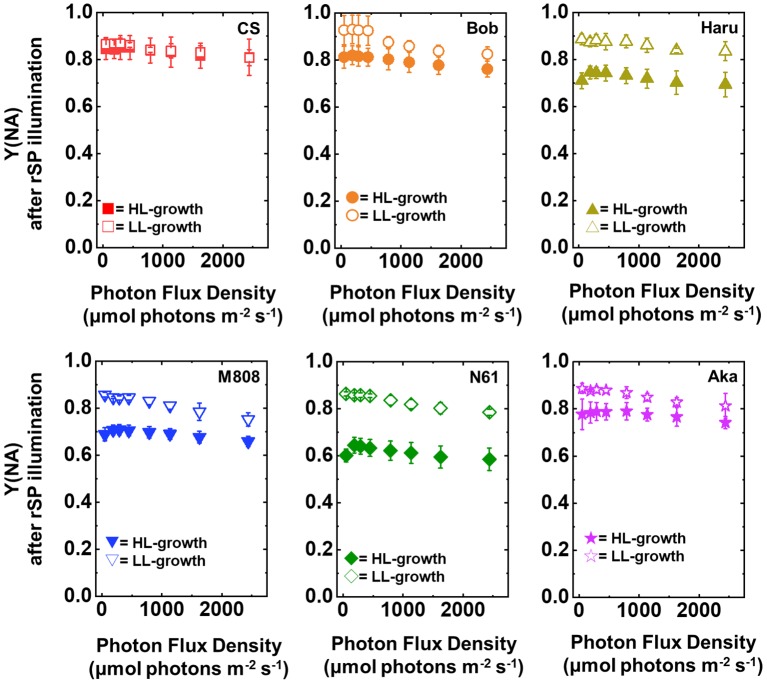
The response of Y(NA) to light intensity in six wheat cultivars grown under LL (open symbol) and HL (closed symbol) conditions after rSP illumination for 1 h. The measurement was conducted under atmospheric conditions (21 kPa O2, 40 Pa CO2) at 25°C. Data are expressed as mean ± SD of three to four independent experiments. Red squares indicate the results of CS, orange circles indicate the results of Bob, dark yellow triangles indicate the results of Haru, blue inverted-triangles indicate the results of M808, green diamonds indicate the results of N61, and purple stars indicate the results of Aka.